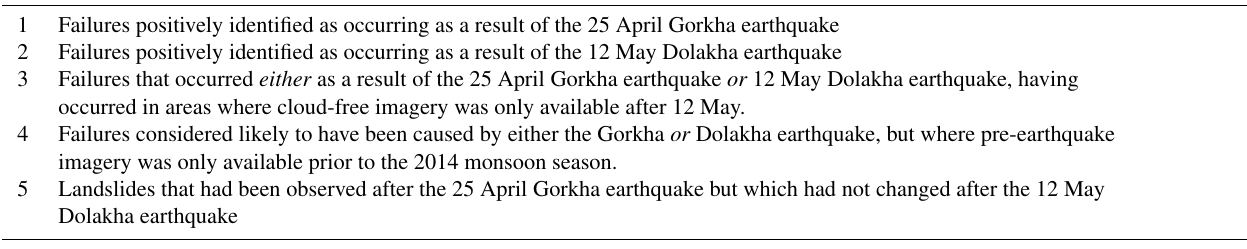
Table 1. Example of notes that accompanied the map released on 18 June, an extract from which is presented in Fig. 6. The Dolakha aftershock on 12 May (15 days after the 25 April mainshock) prompted a second campaign of mapping in response to reports of further landslides close to its epicenter. In the week following 12 May, the majority of new optical imagery was acquired with incidence angles of 25–45 ◦ . Given the extreme relief in the epicentral region, it was decided to delay mapping until imagery that was more suitable became available. A landslide map derived from imagery collected after both earthquakes was therefore not released until